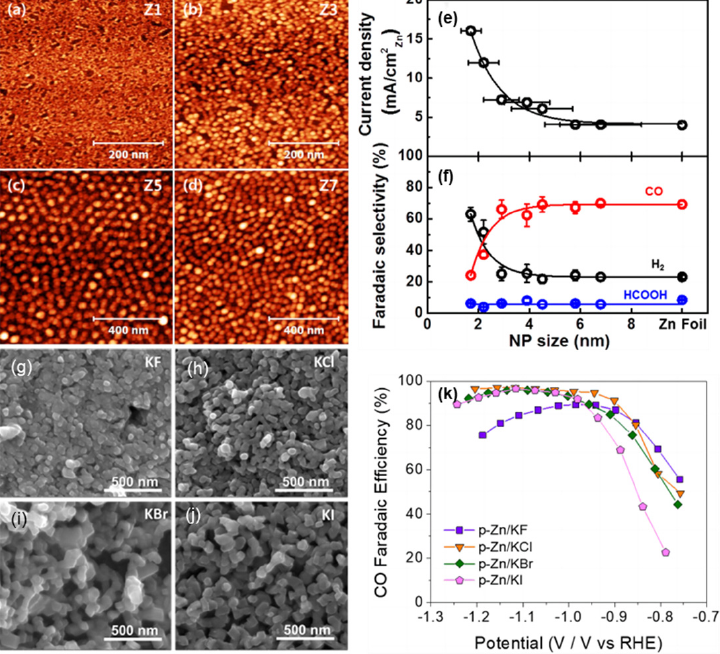
Figure 5. ( a – d ) AFM images of Zn NP samples prepared via inverse micelle encapsulation and supported on SiO 2 /Si (111). Zn 1 (1.7 ± 0.4 nm), Zn 3 (2.9 ± 0.7 nm), Zn 5 (4.5 ± 1.2 nm), and Zn 7 (6.8 ± 1.6